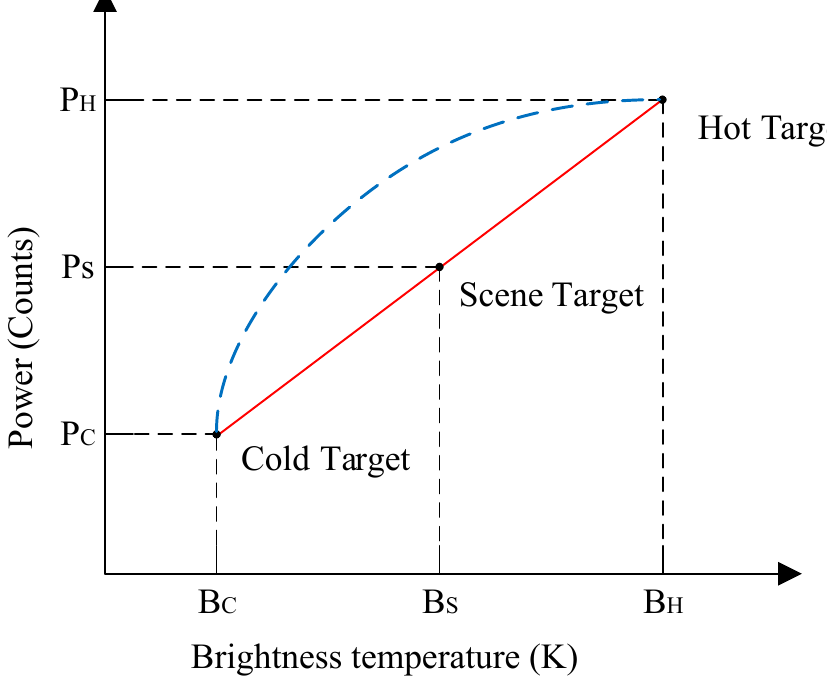
Figure 8. Schematic diagram of two-point calibration.